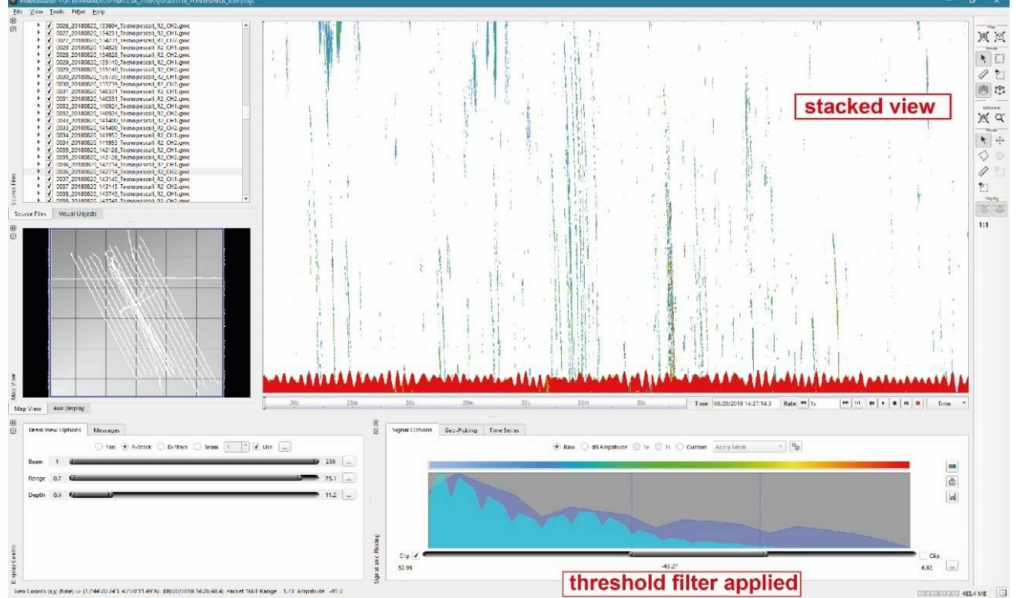
Figure 3. Manually filtered plumes in the FMMidwater Stacked View with background noise